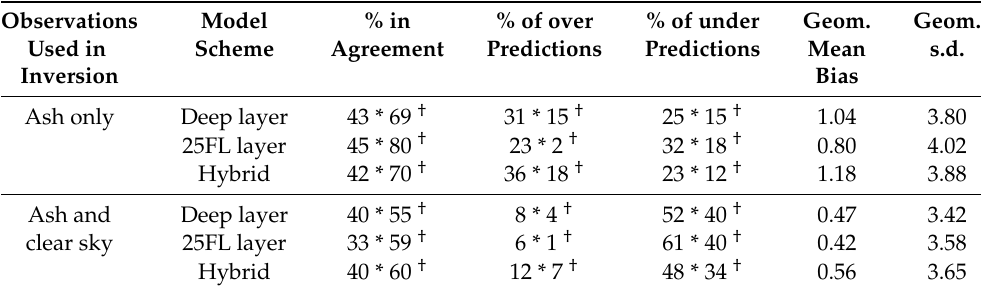
Table 2. Statistical comparison of modelled ‡ and observed § peak concentrations for the Eyjafjalla- jökull 2010 eruption. Observations Model % in % of over % of under Geom.